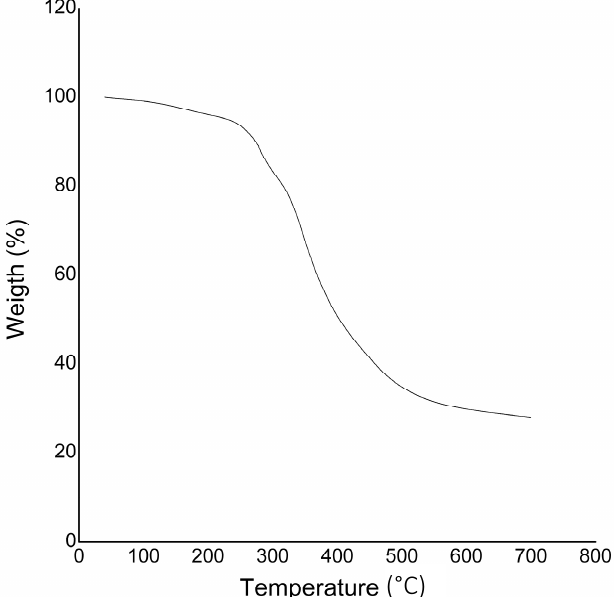
Figure 3. Thermogravimetric analysis (TGA) of alginate/gelatin spheres activated with glutaraldehyde.